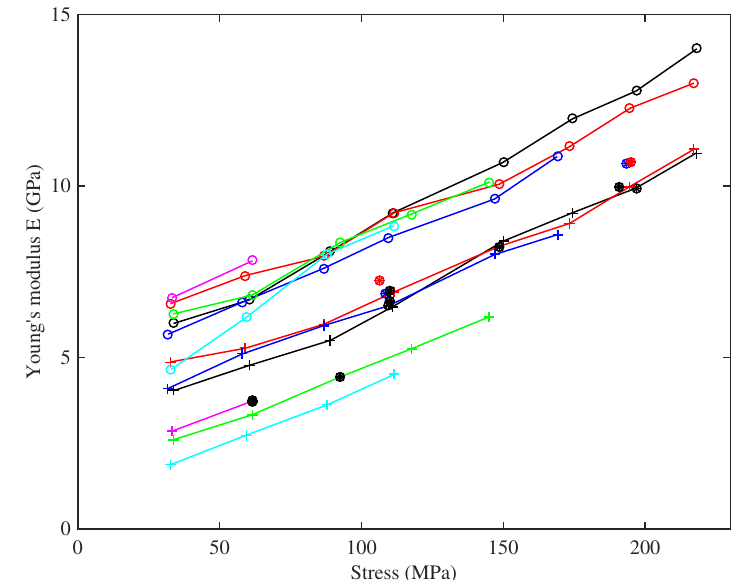
Figure 10. Young’s modulus at the base temperature of 20 ◦ C plotted against the applied stress, measured from bending sti ff ness (o) and by modulating the string tension ( + ). Colours identify the di ff erent tested strings (Table 1): black (8:A6), red (14:A5), blue (5:A4), green (23a:A3), cyan (29:E3), magenta (10b:A2). Black circles show the results at the expected operating points for the Bowbrand strings tested at the usual humidity levels (around 55–65% RH at 20 ◦ C); blue circles show Pirastro strings; red circles show tests at low humidity (around 20–26% RH at 20 ◦